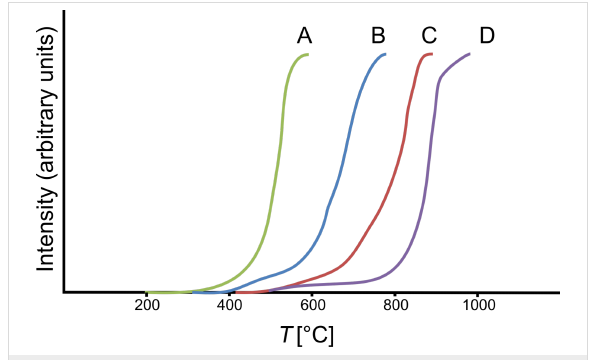
Figure 7: TPO measurements of CeO 2 nanoparticles (A), SiC-Acr/ CeO 2 (B), SiC/CeO 2 (C) and the unloaded SiC shell, not containing Cerium